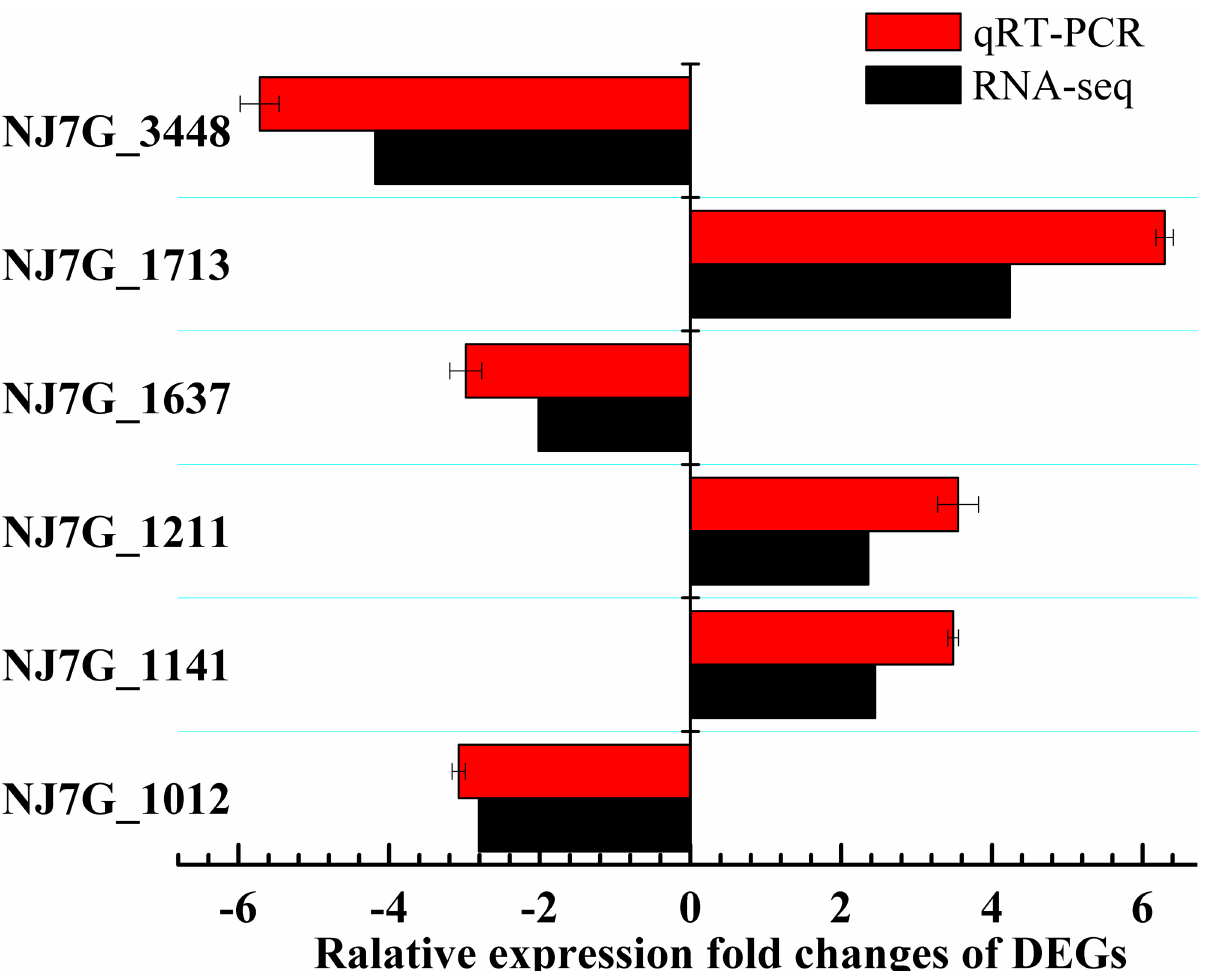
Fig 4. Validation of DEGs by qRT-PCR. Six DEGs riched to the membranelipid and energy metabolismfrom RNA-seq were selectedto validate by real-time PCR.